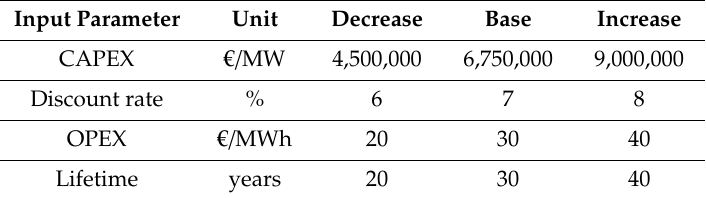
Table 17. The sensitivity of the system levelized cost of energy (LCOE) to input parameters.